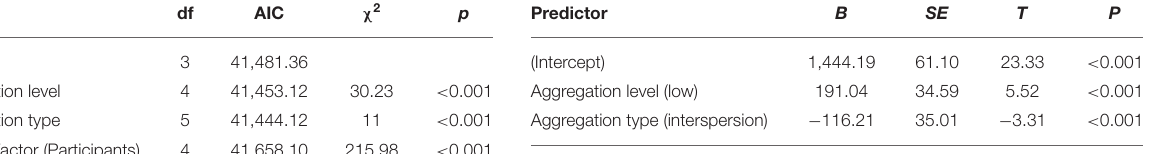
TABLE 5 | Linear mixed model results for total fixation time as a function of aggregation level (low-high) and aggregation type (dispersion-interspersion). Model df